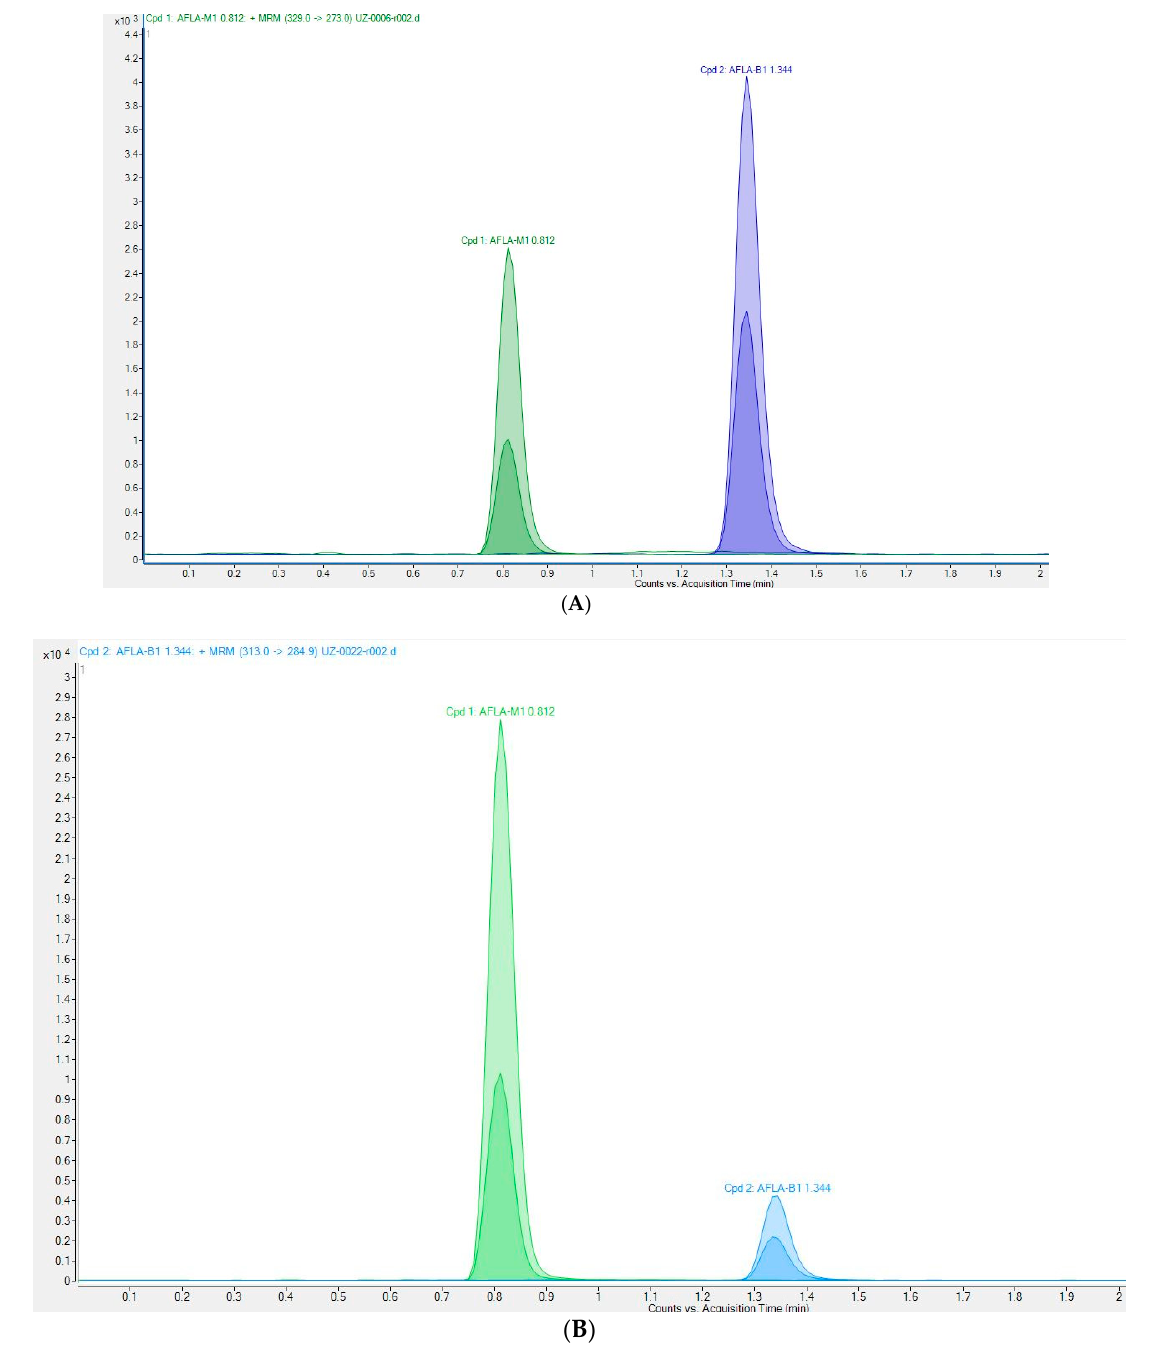
Figure 2. Chromatograms of AFM 1 : ( A ) spiked milk sample at 50 ng/kg; ( B ) positive milk sample (434.1 ng/kg).